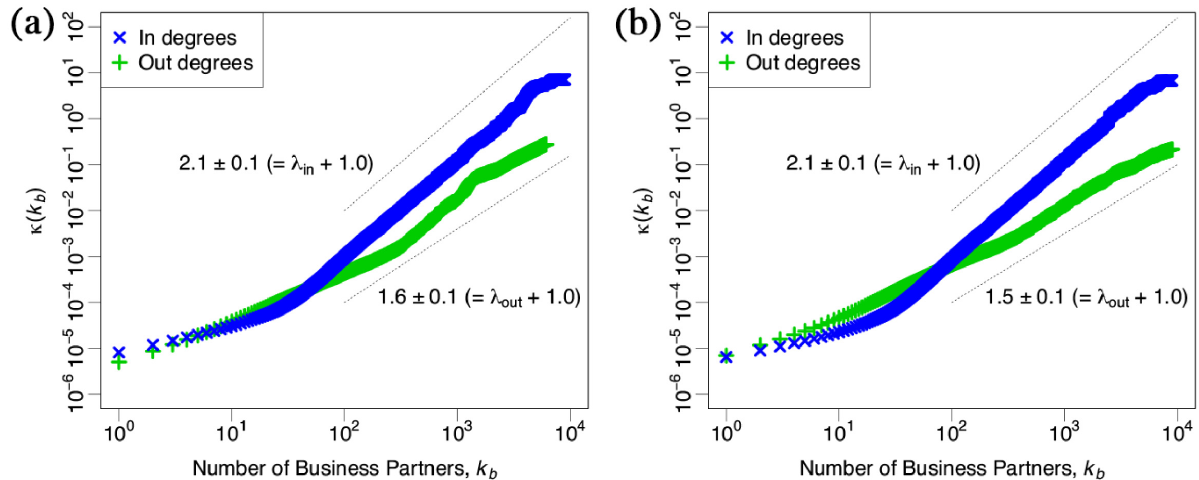
Fig 4. Scaling relation of the rate of fitness as a function κ ( k and (b) shows this relation of newcomers and new links on the citation network, respectively. Each red triangle and green plus-mark shows κ ( k b ) by out-degrees and in-degrees, respectively. Both upper and lower dotted lines indicate the power law distributions with the exponent λ λ out = 0.6 ± 0.1,